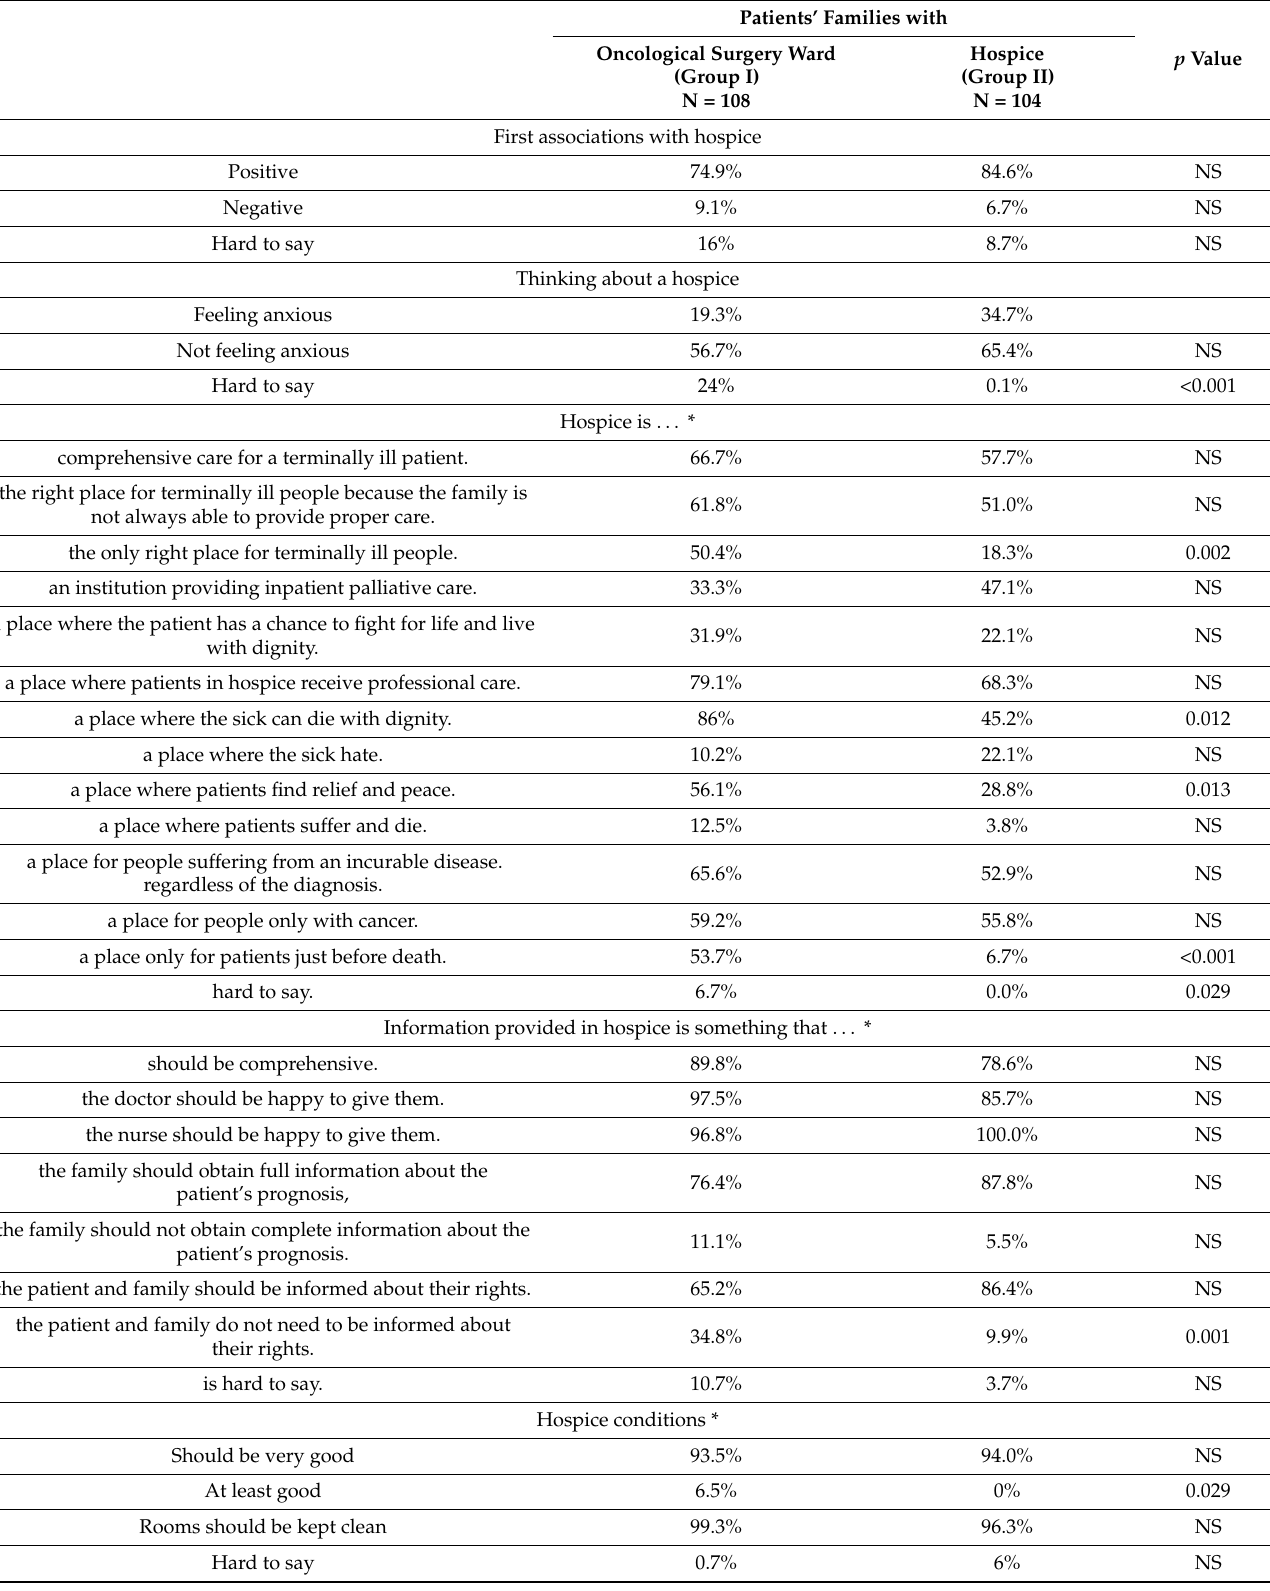
Table 5. The respondents’ opinions about